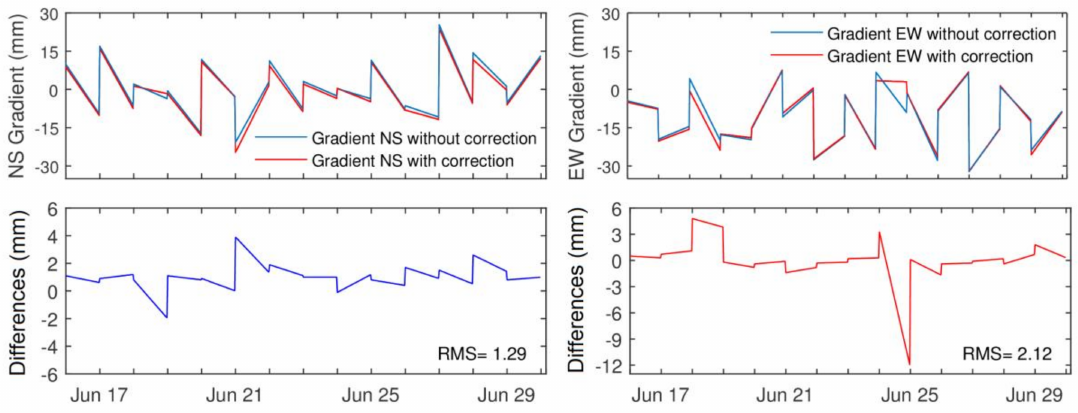
Figure 3. NS ( left ) and EW ( right ) gradients time series ( top ) and di ff erences ( bottom ) at the DIYB GPS station on days 168–180 in